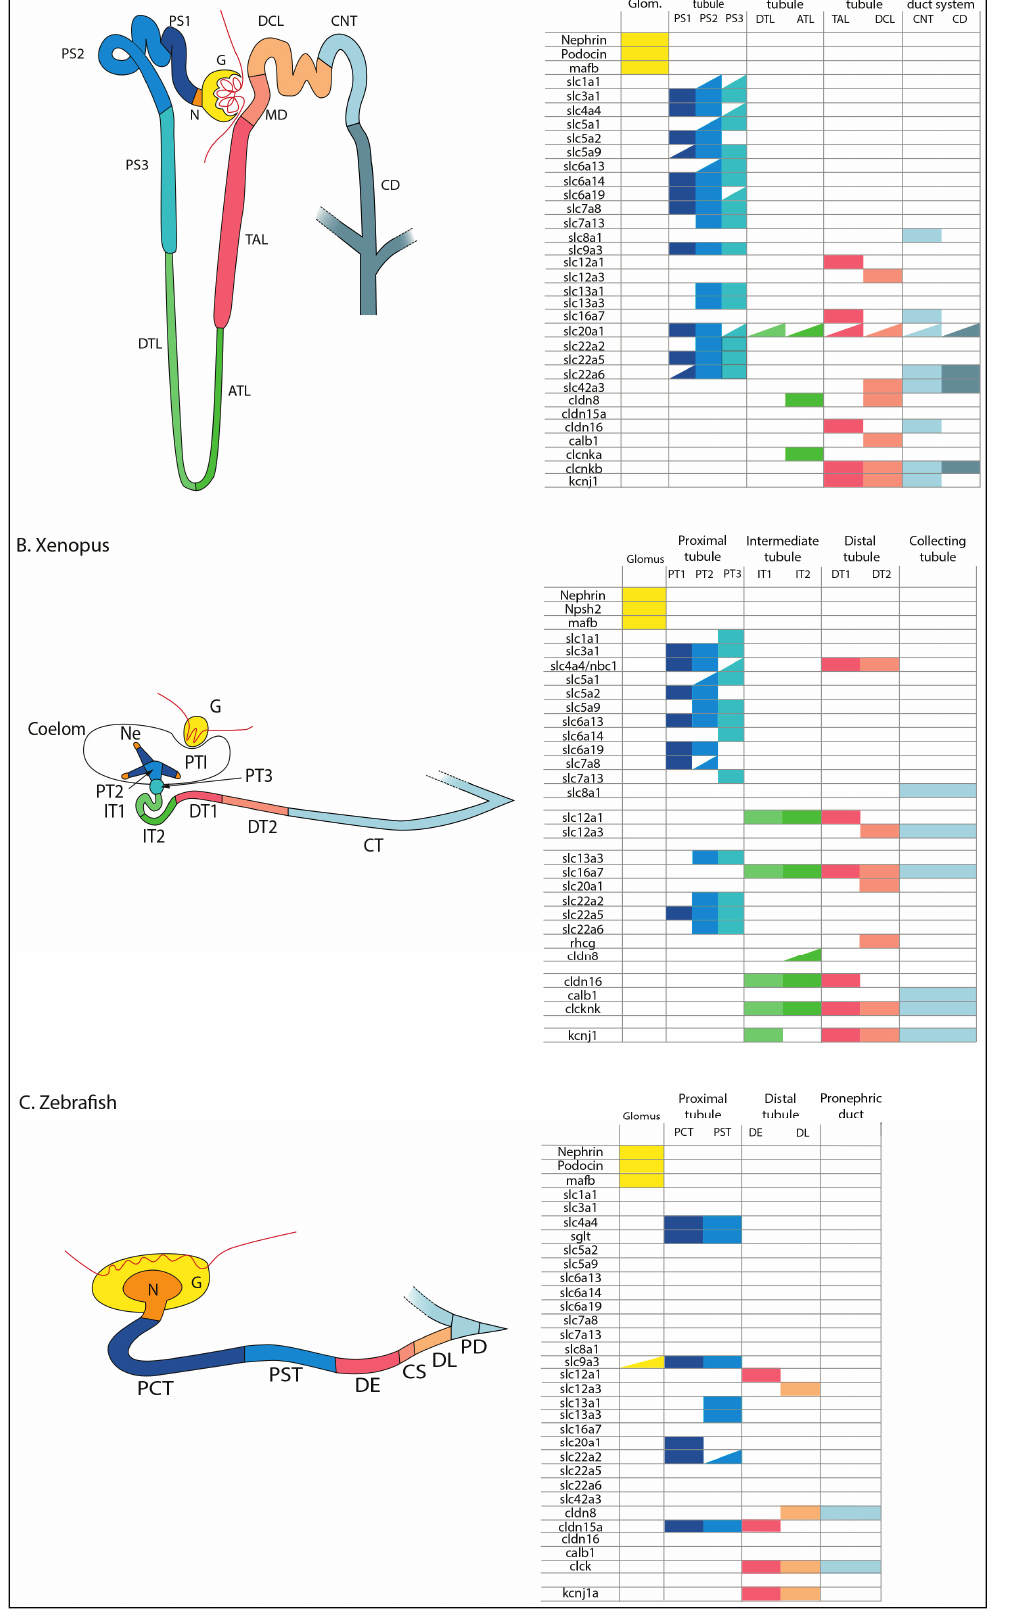
Figure 2. Nephron segments and table of expression of marker genes. The different segments are depicted schematically with different colors showing the co-expression of selected markers in different segments in mature mouse/mammalian metanephric kidney ( A